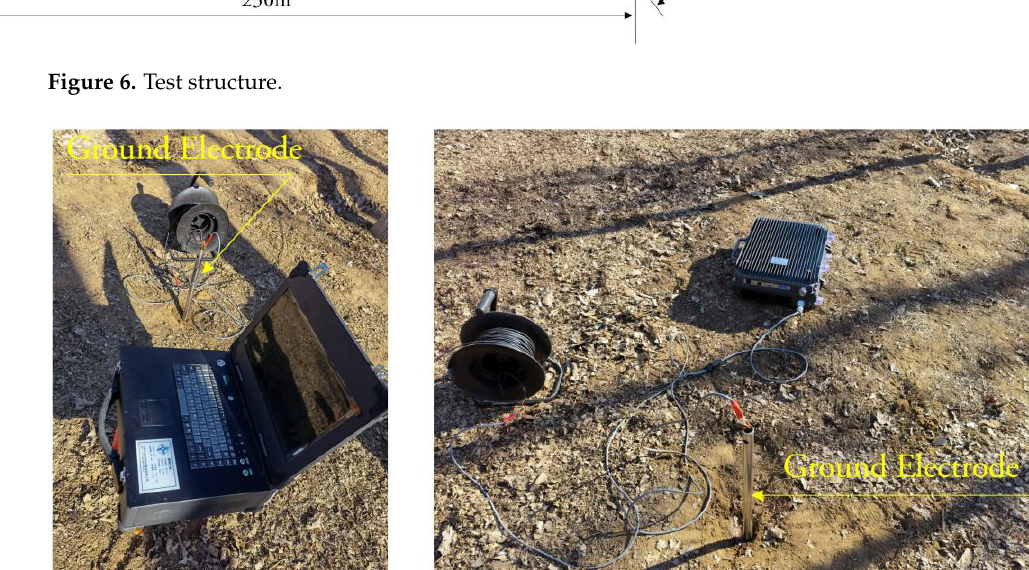
Figure 7. Test site.